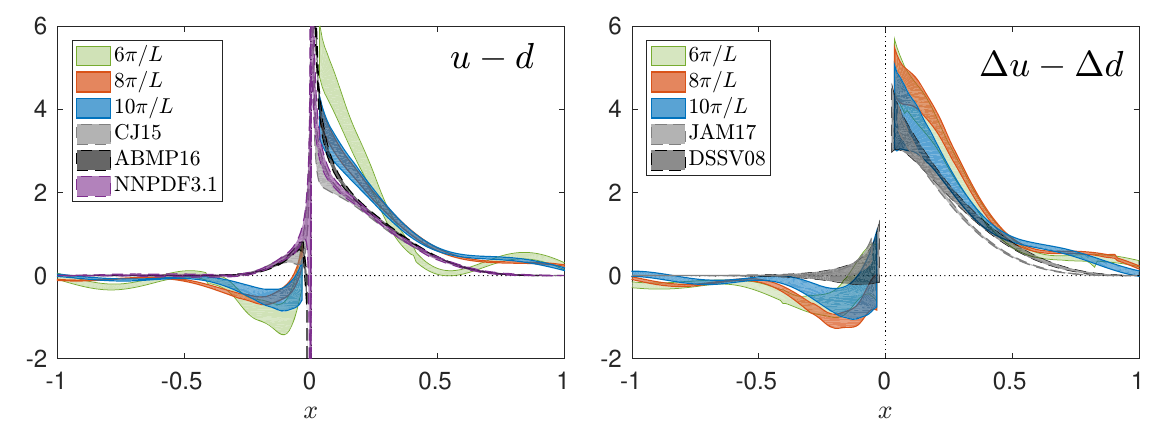
Figure 9. Unpolarized (left) and polarized (right) parton distribution functions for three momenta compared to some phenomenological curves. Results are from Ref. [10].